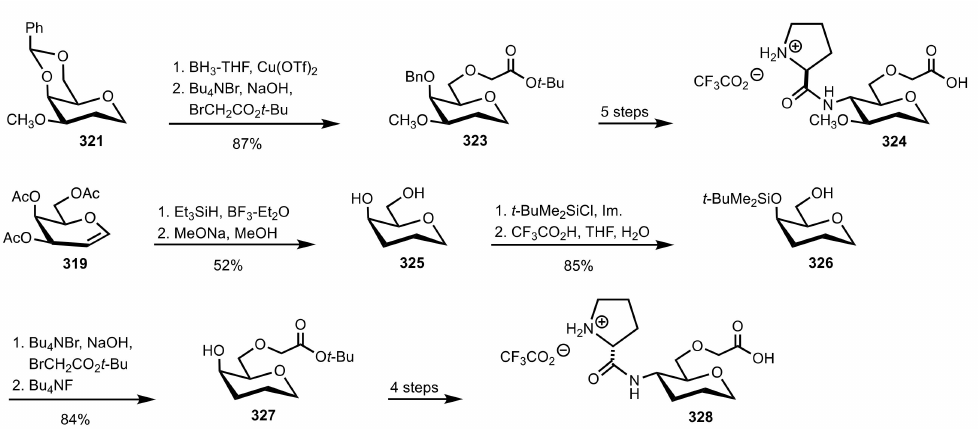
Scheme 88. The synthesis of the sugar prolinamide organocatalysts 324 and 328